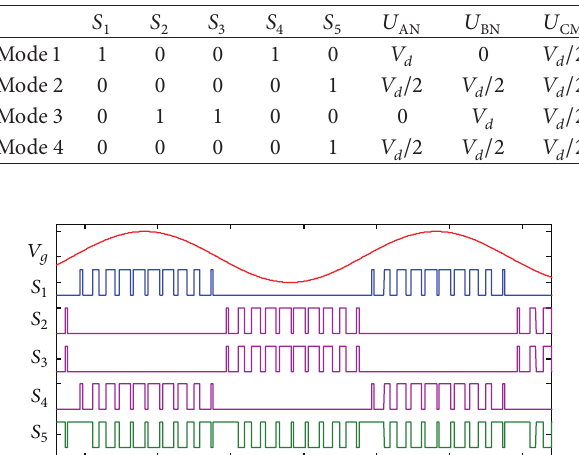
Table 1: Four operation modes and common mode voltage.